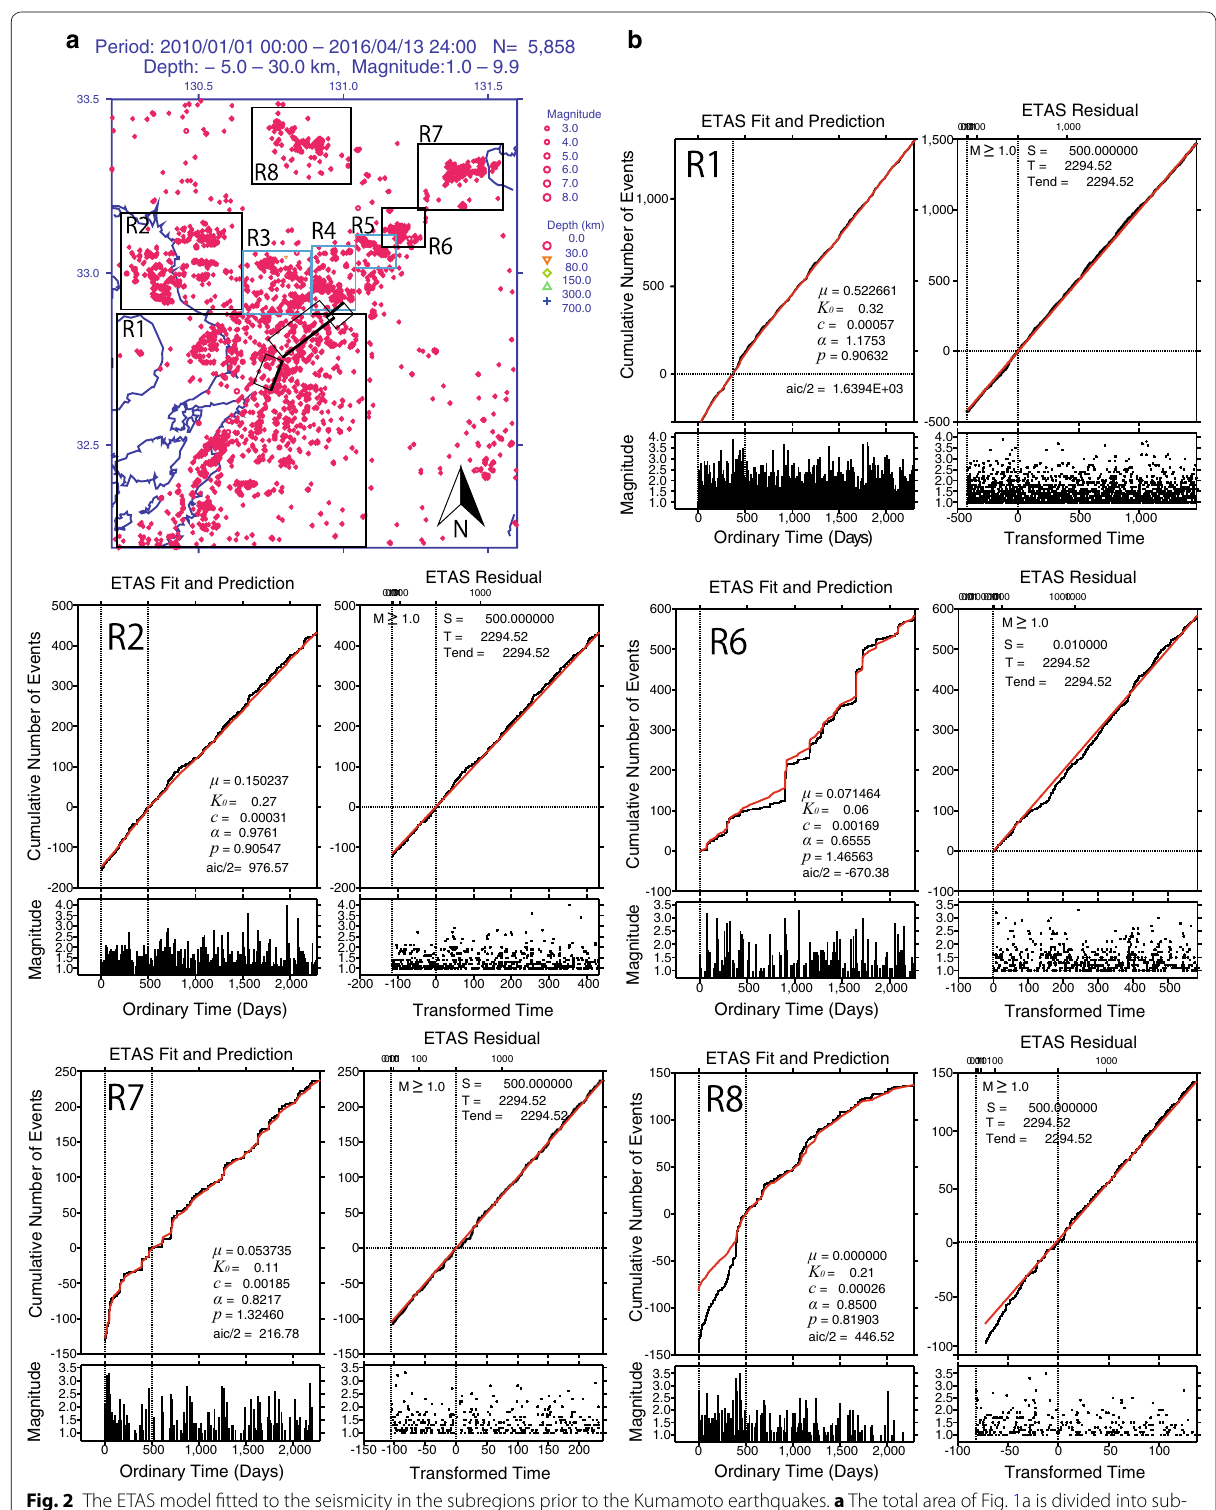
Fig. 2 The ETAS model fitted to the seismicity in the subregions prior to the Kumamoto earthquakes. a The total area of Fig. 1a is divided into sub- regions R1–R8. The thin rectangles indicate the fault models (Geospatial Information Authority of Japan 2016). b The ETAS estimate of the cumula- tive curve (red curve) is superimposed on the observed cumulative curve (black curve) in ordinary time (the left side of each pair) and transformed time (the right side of each pair). The corresponding M–T plots are attached at the bottom of each